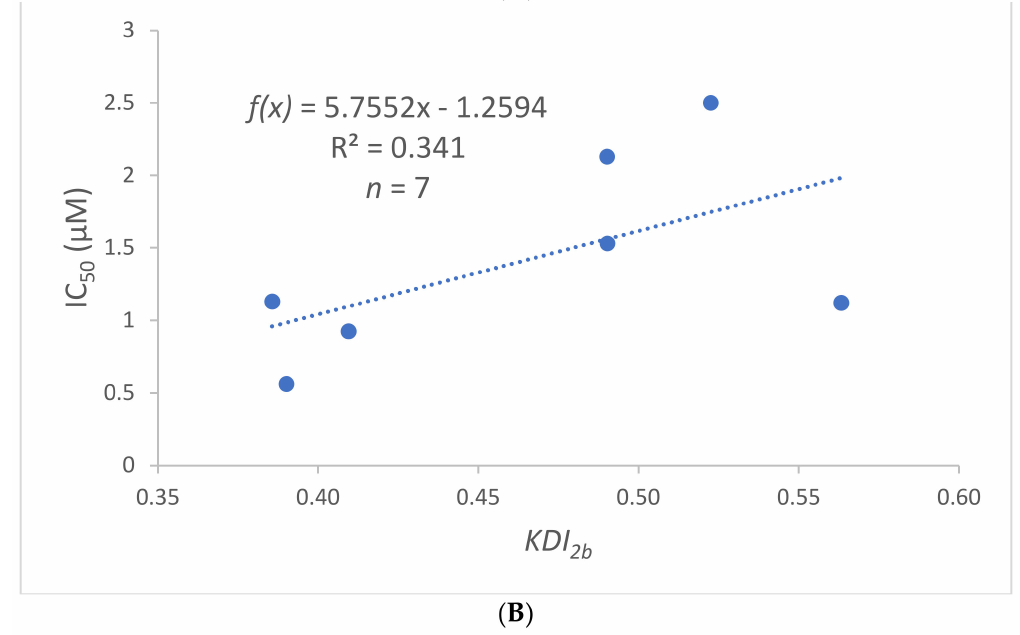
Figure 12. The correlations between KDI 2a ( A ) and KDI 2b ( B ) with their corresponding IC 50 values. Smaller KDI values favor increased